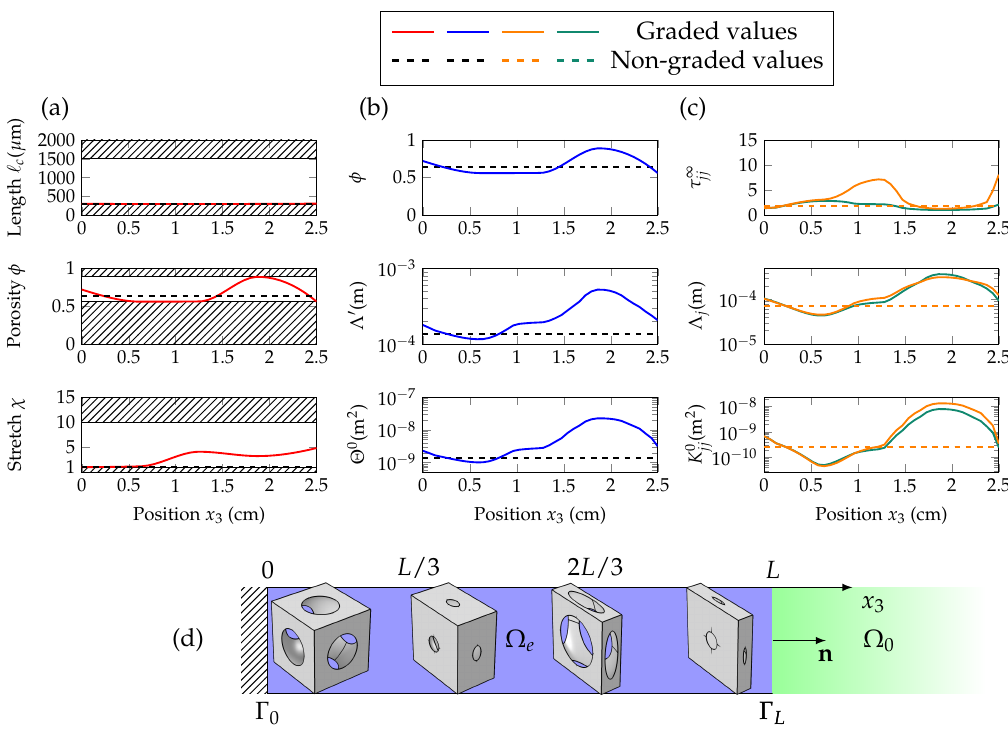
Figure 7. (Color online) Components of the vector of geometric parameters W g (characteristic length (cid:96) c , porosity φ and stretch χ ) are shown in ( a ), as a function of the position x 3 . Scalar JCAL parameters ( φ , Θ 0 , Λ (cid:48) ) are given in ( b ) and direction-dependent ones ( τ ∞ ⊥ , τ ∞ ( c ), with respect to x 3 . The graded values are in solid lines, and the non-graded ones in dashed lines; in orange for the normal direction, and in green for the transverse direction. The sketch in ( d ) displays snapshots of the unit cells at intervals of L /3 between interfaces Γ 0 and Γ L